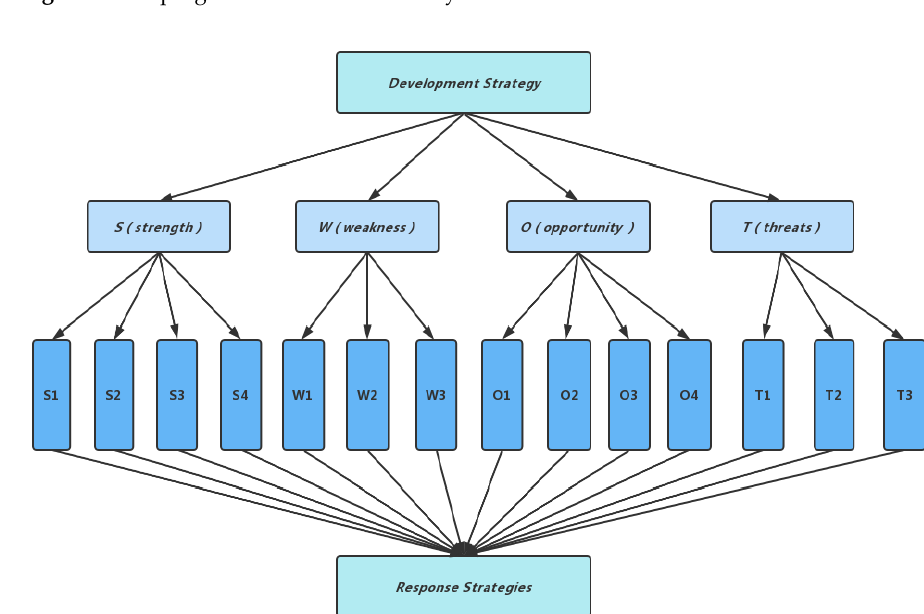
Figure 2. Hierarchical analysis structure graph.